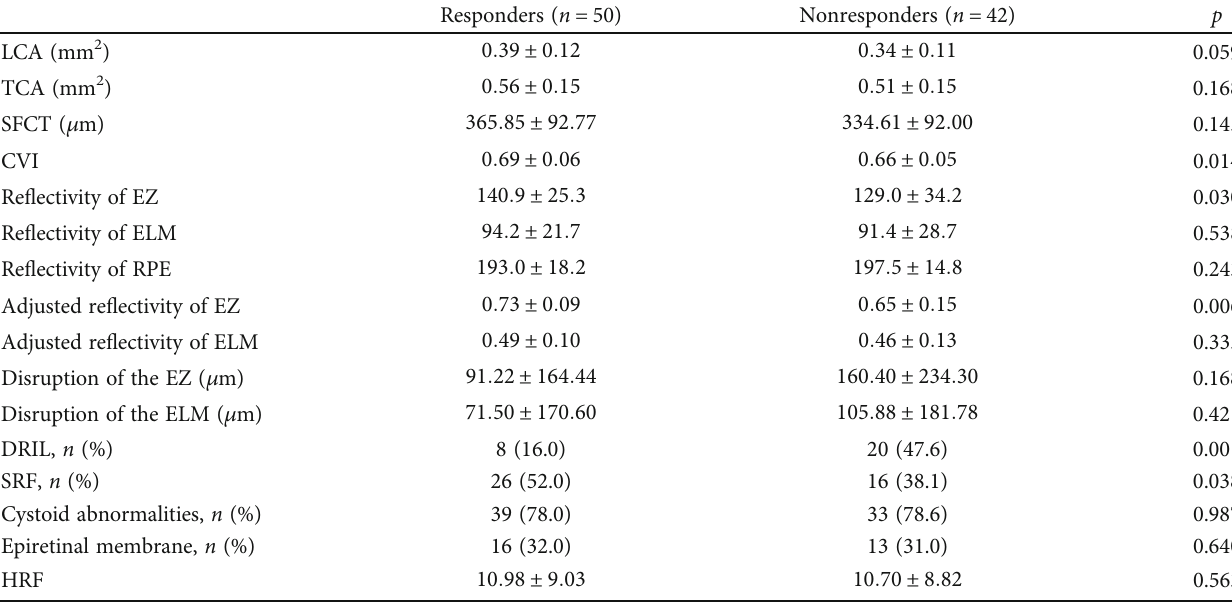
Table 2: Baseline optical coherence tomography morphological feature comparison between responders and nonresponders by a generalized estimating equation model with adjusting for correlation between two eyes within the same patient ( N = 92 eyes).